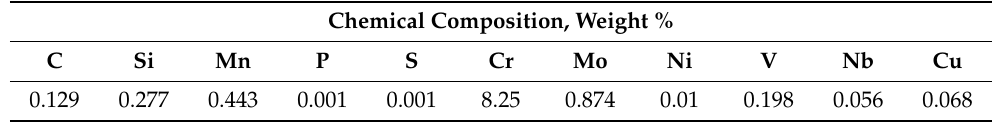
Table 1. Base metal chemical composition, steel SA-387 Gr. 91.